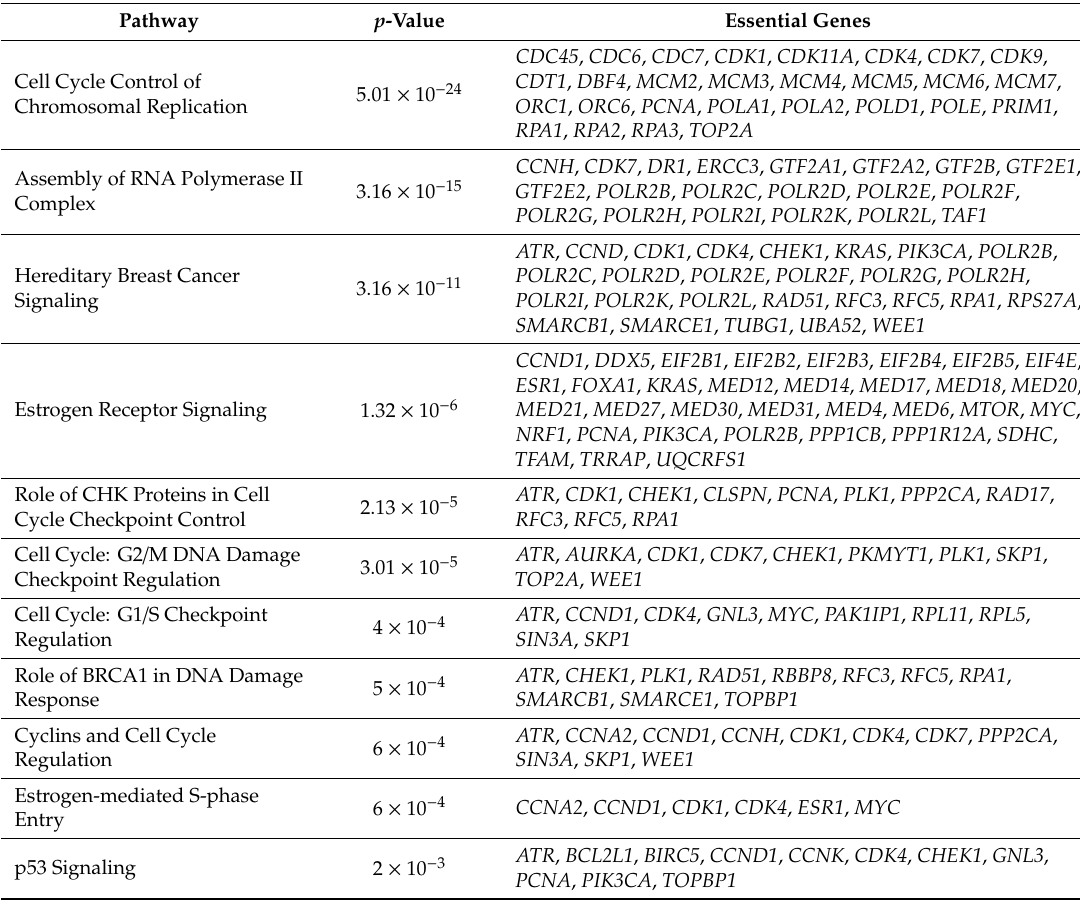
Table 3. Canonical pathway analysis performed on ER + BC essential